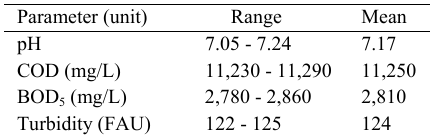
Table 1: Sampled raw leachate characteristics